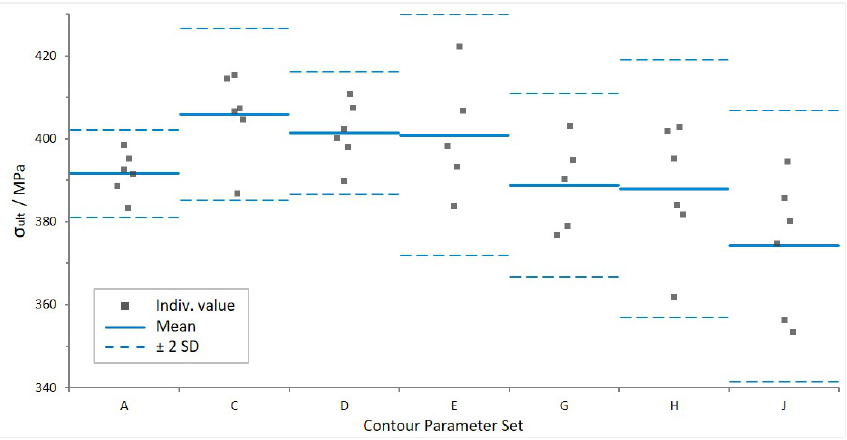
Figure 7. Ultimate tensile strength for seven different surface conditions, mean ±